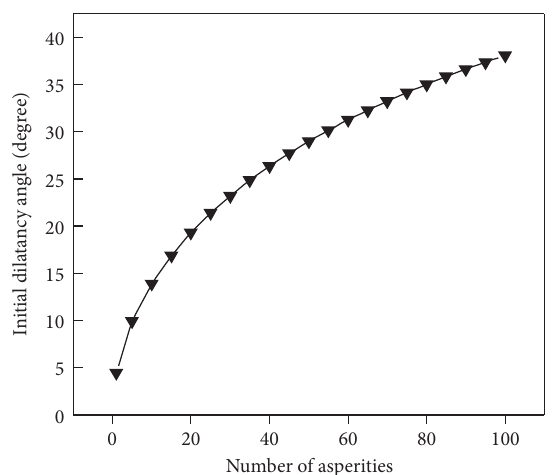
Figure 9: Changes of the initial dilatancy angle versus the number of asperities in the first sliding.